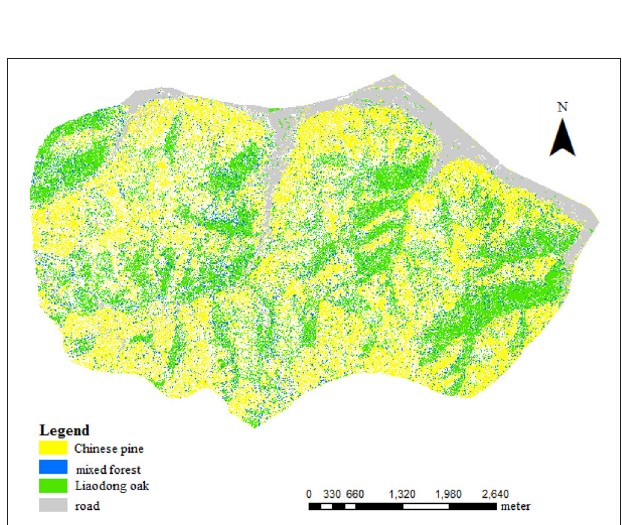
FIGURE 3 | The operation steps of remote sensing images classification based on object.